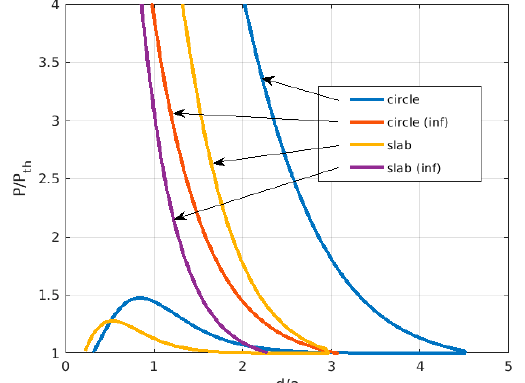
Figure 6. Stability boundaries in the plane of P / P th versus d / a for coupled circular cylindrical guides with v = 1.571. Curves labelled ‘inf’ are obtained using the values of overlap factors in the limit of large d / a . Photonics 2019 , 6 , x FOR PEER REVIEW